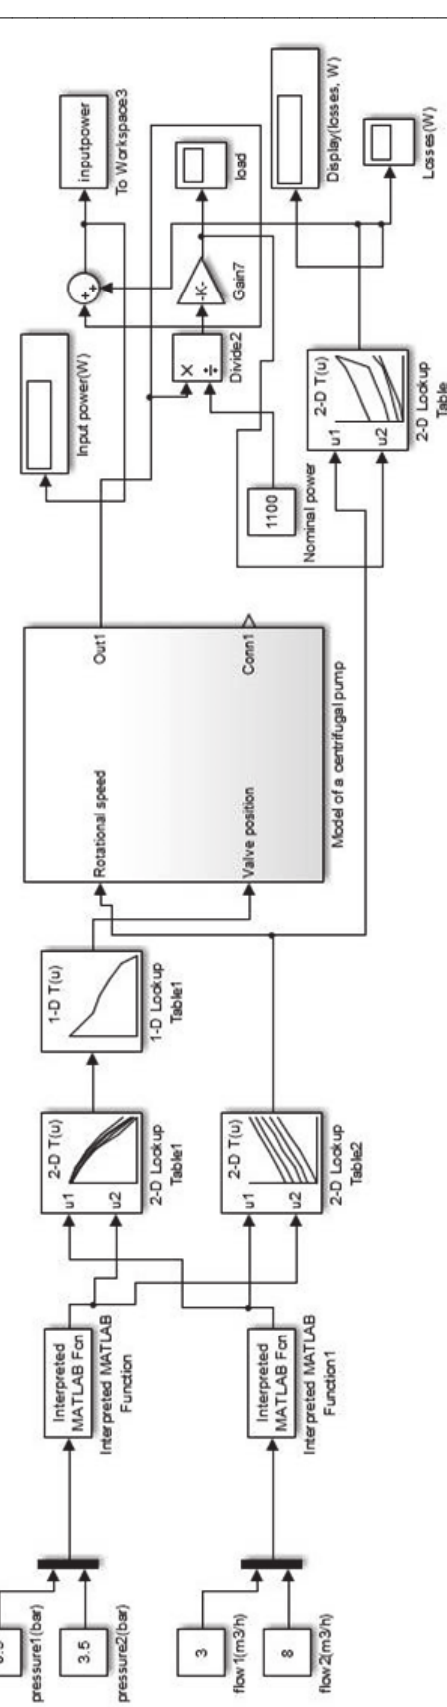
Fig. 3. Model of the mixed control system for a centrifugal pump.